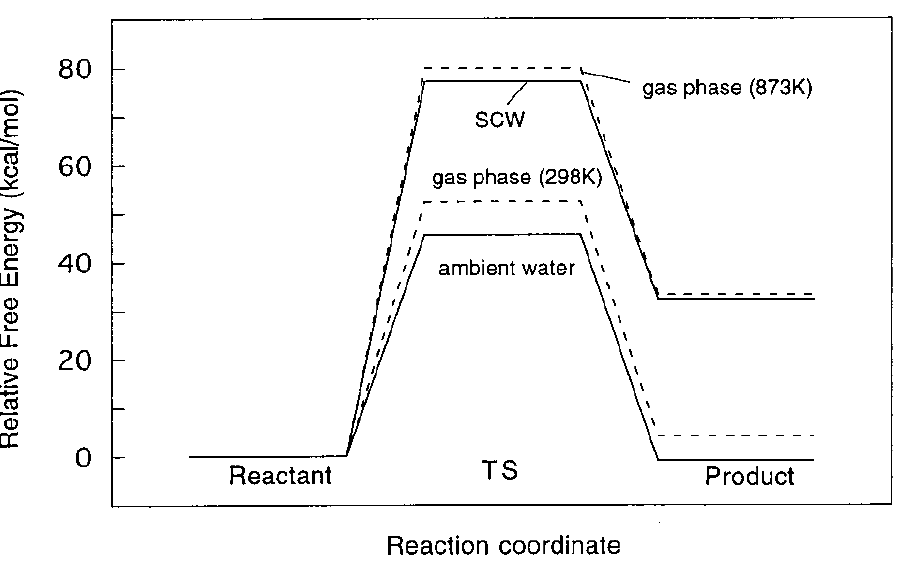
Figure 17. The total free energies of TS and the products relative to those of the reactants for the endo–trans reactant. This figure is reprinted with permission from JACS , 2000 , 122 , 2289. Copyright 2000 American Chemical Society. The activation free energies in the gas phase and AW are 52.48 and 45.58 kcal/mol, respectively: there is a reduction by 6.90 kcal/mol from the gas phase to AW (Table 1). The change is attributed essentially to the differences in the electronic reorganization energy, ∆ E ‡ = E ( TS ) − E ( reactants ) , and the solvation free energy, ∆ µ ‡ = ∆ µ ‡ ( TS ) − ∆ µ ( reactants ) , re re re between the reactant and TS. Changes in the activation free energy from the gas phase to